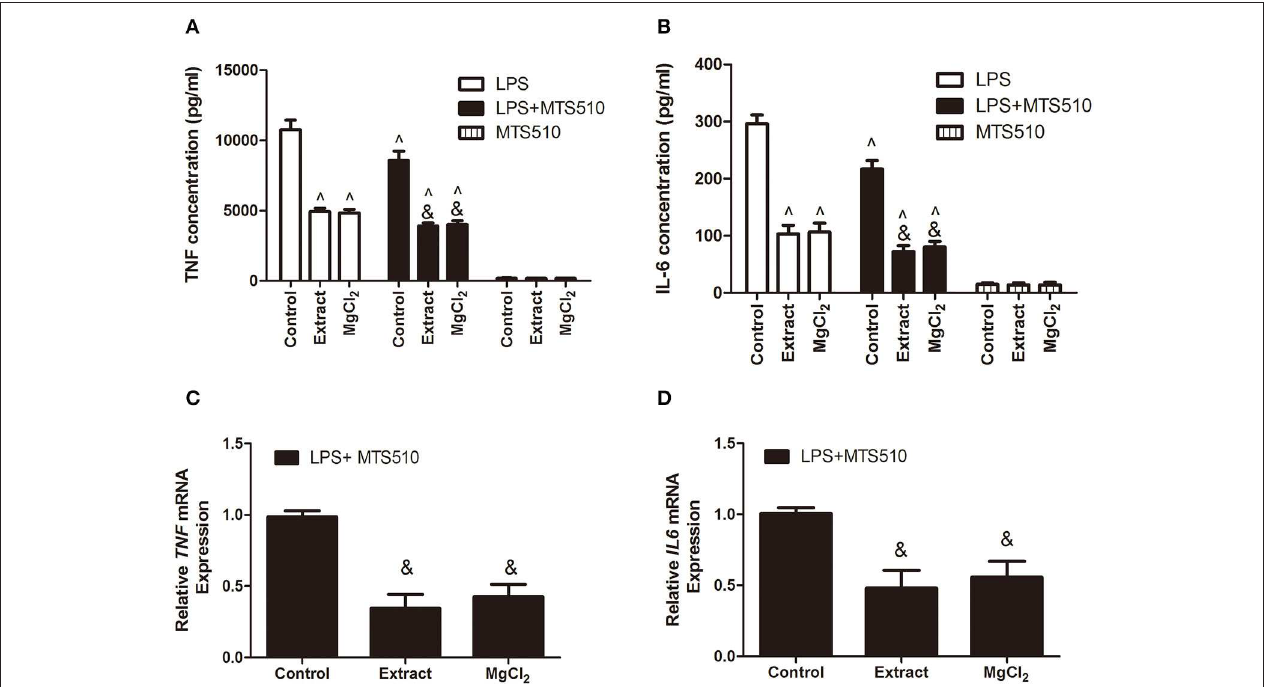
FIGURE 4 | Effects of extract and MgCl 2 on the expression of pro-inflammatory cytokines of THP-1 cell-derived macrophages through regulation of the TLR-4 pathway. THP-1 cell-derived macrophages were pretreated with anti-TLR-4 antibody (MTS510, 3 µ g/ml) for 1h prior to the addition of extract or MgCl 2 for another 1 h and then stimulated with LPS for the indicated time. The protein expression of TNF (A) and IL-6 (B) in supernatant was measured by ELISA at 24h. The mRNA expression of TNF (C) and IL-6 (D) was analyzed with qPCR at 6h. & P < 0.05 vs. LPS + MTS510 control group; ∧ P < 0.05 vs. LPS-induced control group. TLR, toll-like receptor; LPS, lipopolysaccharide; TNF, tumor necrosis factor; IL,